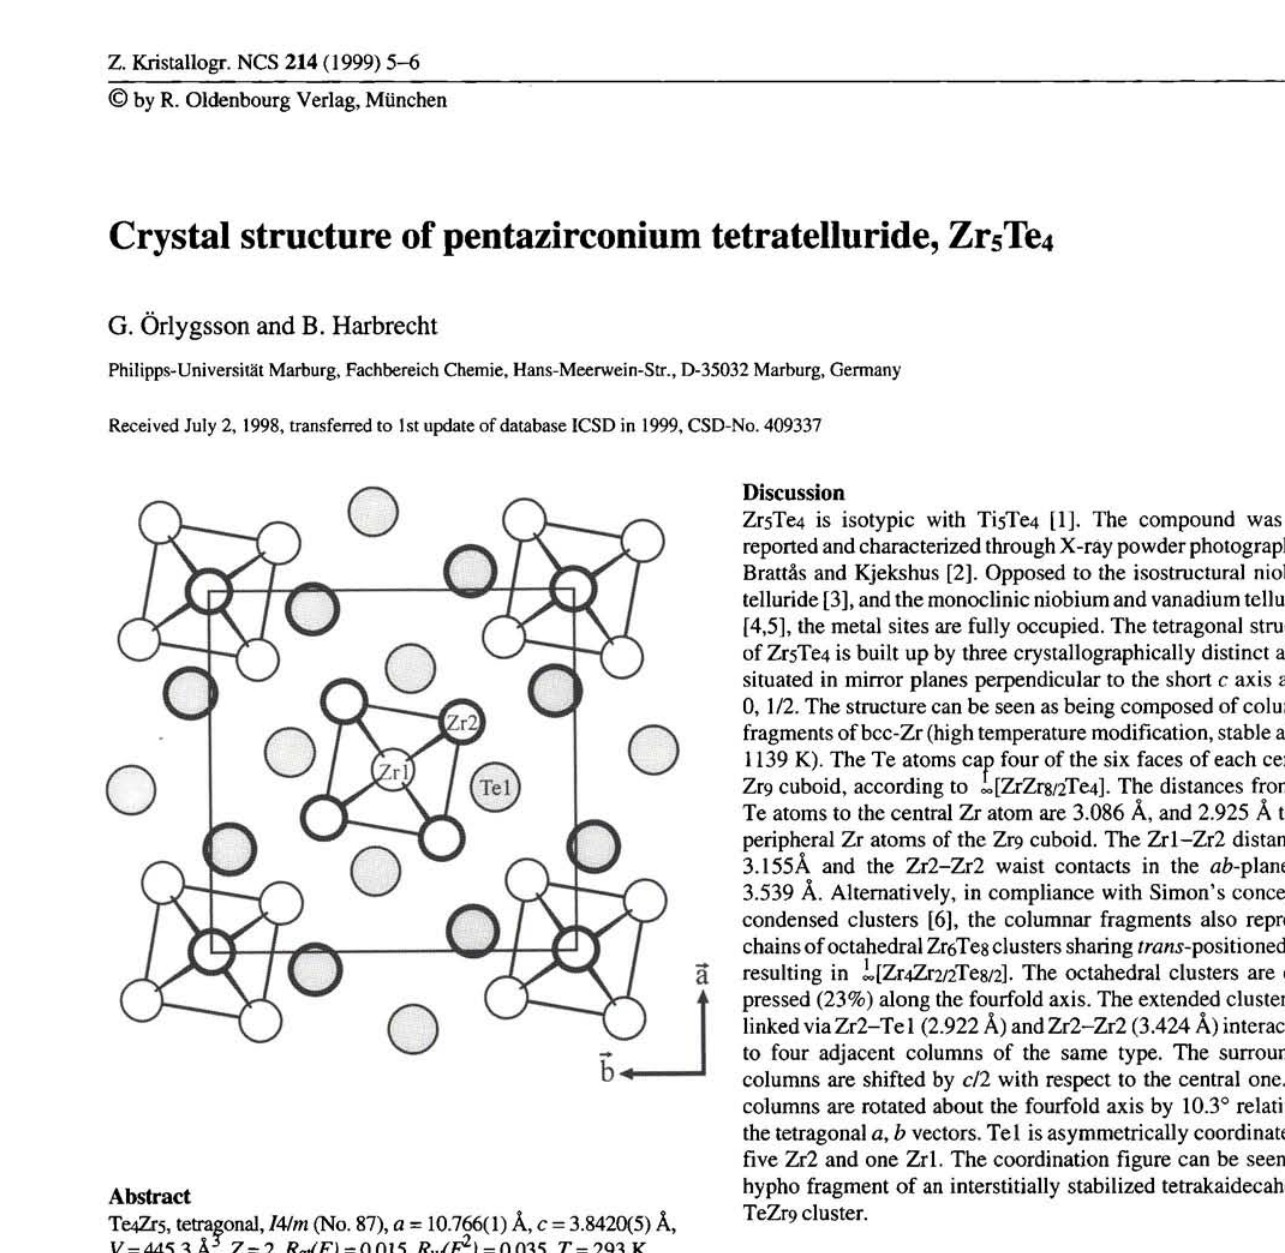
Te4Zr5, tetragonal, 74/m (No. 87), a = 10.766(1) Â, c = 3.8420(5) Â,